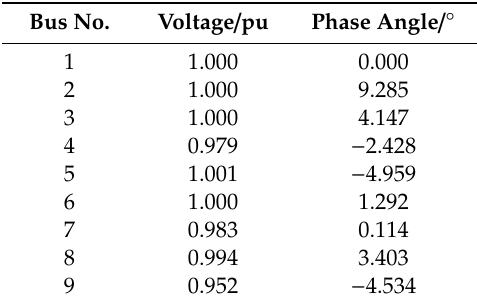
Table 1. Bus voltage results.